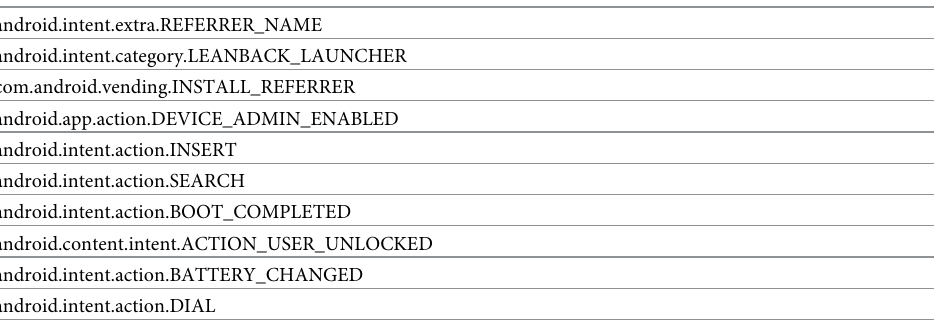
Table 6. The top ten intents of the frequency similarity weight value.